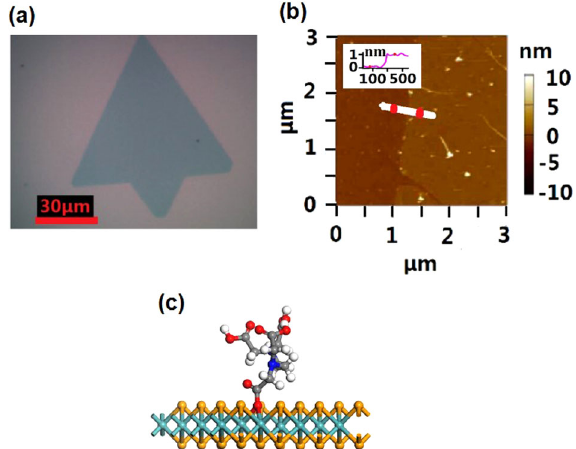
Fig. 1 The original performance of the SLM device. a Optical photograph of monolayer MoSe 2 , b AFM picture of monolayer MoSe 2 , c EDTA absorbed on the SLM. Red : O, White : H, Gray : C, Blue : N